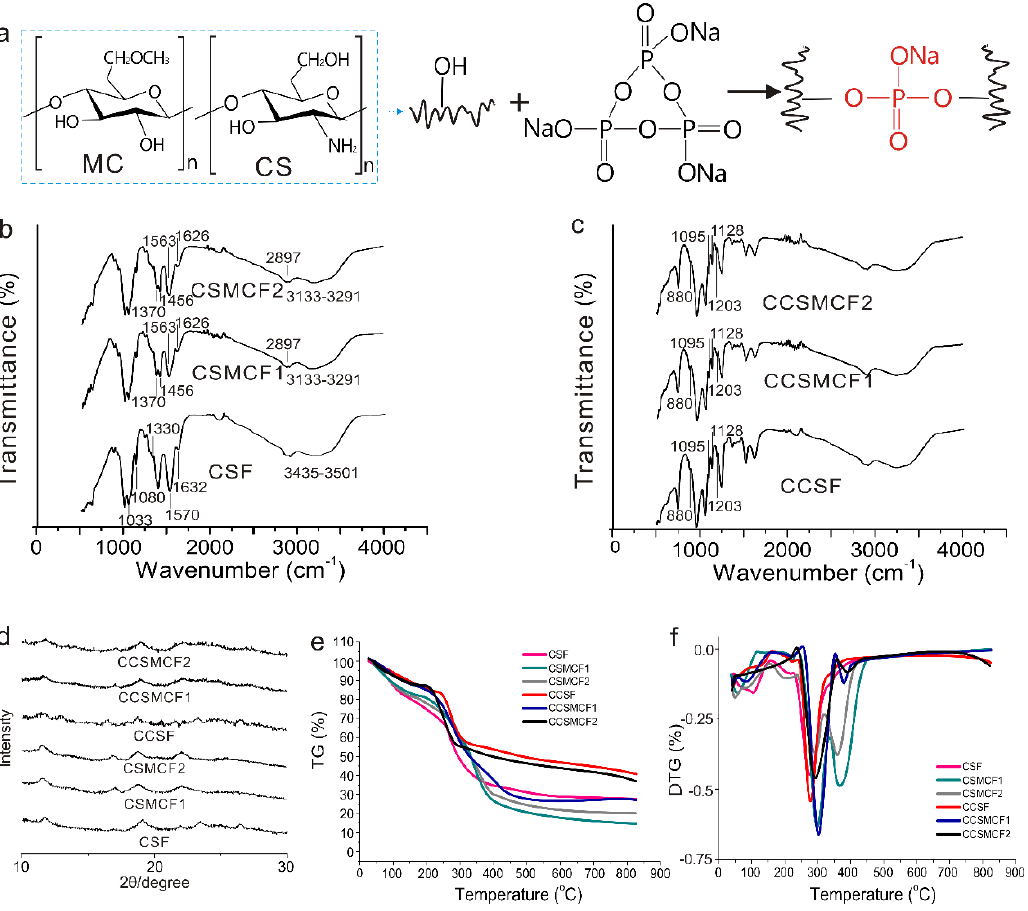
Figure 2. ( a ) The crosslinking reaction between polysaccharides and STMP; ( b ) FTIR spectra of non-crosslinked films; ( c ) FTIR spectra of crosslinked films; ( d ) X-ray diffraction patterns of the prepared films; ( e ) thermograms of the films; ( f ) derivative curves of the